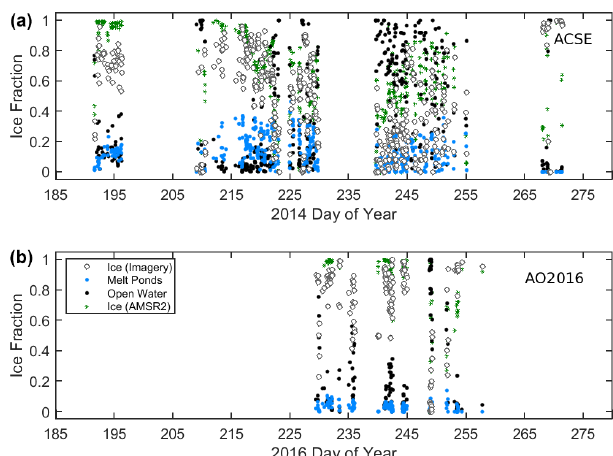
Figure 4. Time series of ice, melt-pond and open-water fractions (white, blue and black symbols respectively) from the local im- agery, and ice fraction (green) from AMSR2, interpolated to the ship location. (a) is for ACSE and (b) for AO2016.